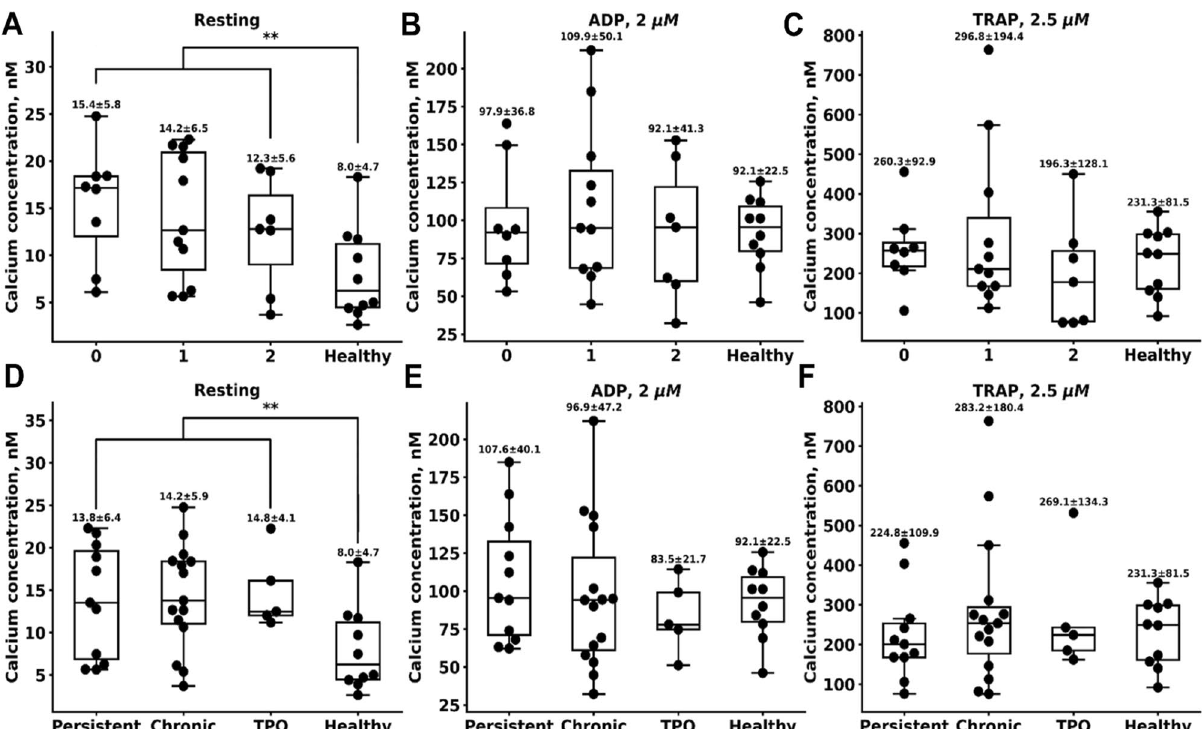
Figure 4. Platelet signal transduction in ITP. ( A – F ) The panels show platelet signalling parameters for ITP patients without bleeding (labeled as 0), mild bleeding (labeled as 1), severe bleeding (labeled as 2) and healthy children (labeled as Healthy). Cytosolic calcium concentration in resting platelets ( A ), maximal increase in calcium concentration upon activation by 2 µM of ADP ( B ) and 2.5 µM of TRAP-6 ( C ) were assessed. ( D – F ) The panels show platelet signalling parameters for acute/persistent ITP (< 1 year, labeled as persistent); chronic ITP (> 1 year, labeled as chronic), chronic ITP on romiplostim (labeled as TPO) and healthy children (labeled as Healthy). Cytosolic calcium concentration in resting platelets ( D ), maximal increase in calcium concentration upon activation by 2 µM of ADP ( E ) and 2.5 µM of TRAP-6 ( F ) were